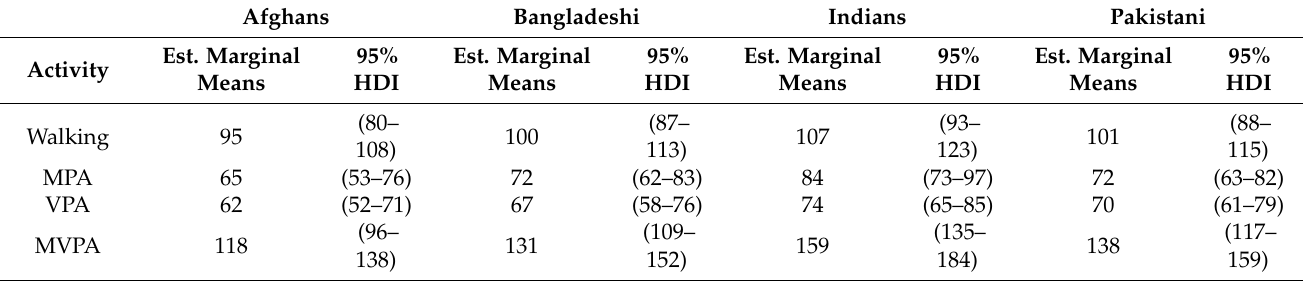
Figure 1. Total minutes of MVPA per week of males and females across the four ethnic groups. Table 2. Estimated marginal means from Bayesian analysis of PA intensities across four ethnic groups.